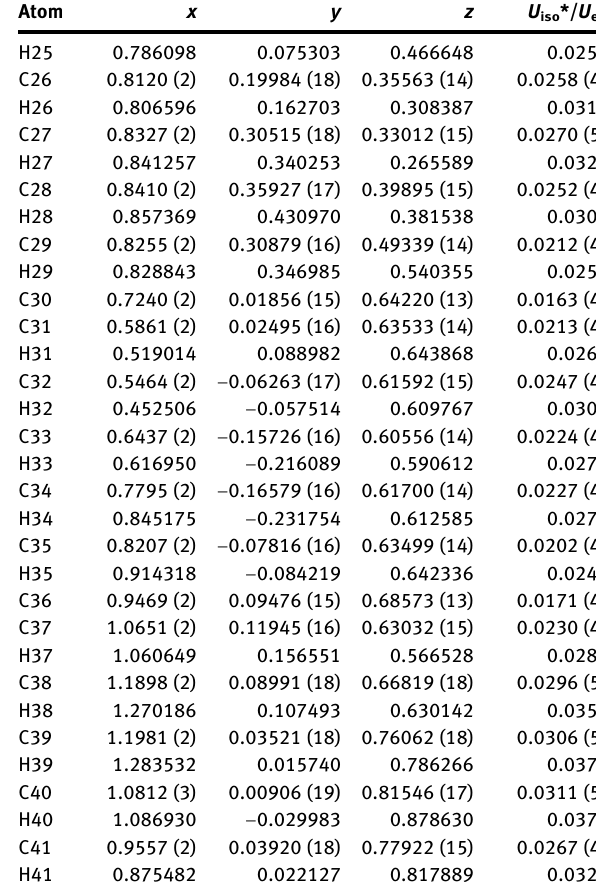
Table  : Fractional atomic coordinates and isotropic or equivalent isotropic displacement parameters (Å 